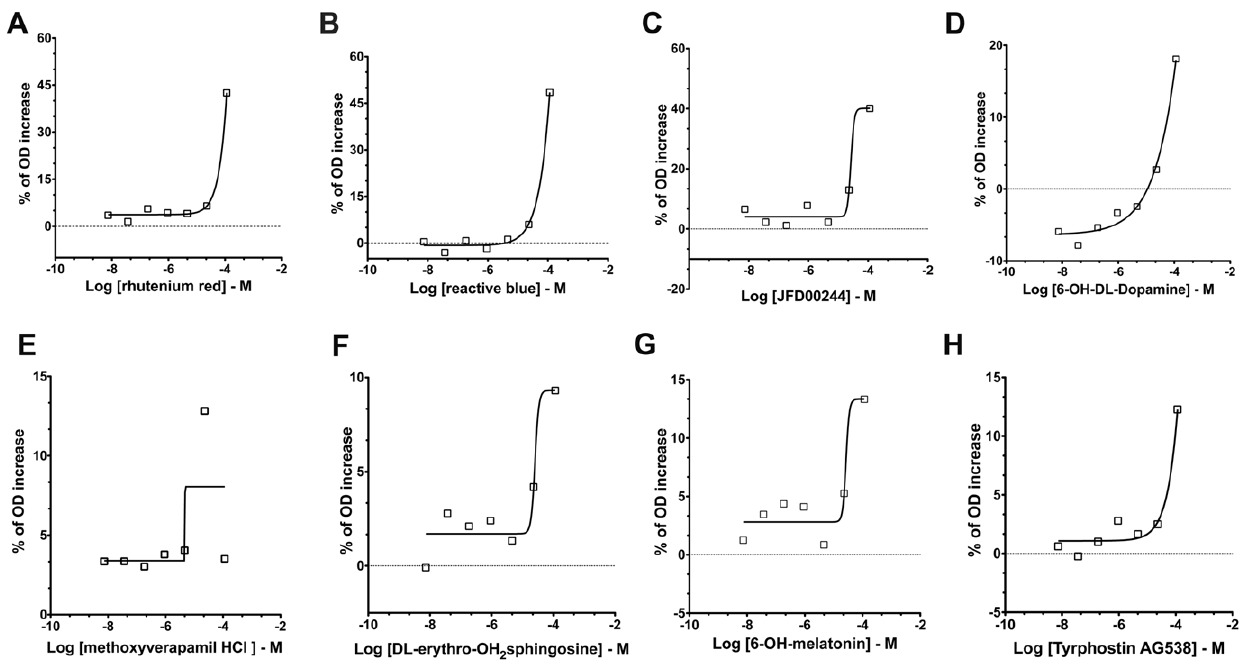
Figure 7. Concentration-response curve analysis obtained from the quantitative cell-based HTS assay for ASA against LOPAC library. In the cell-based HTS for ASA using LOPAC concentrations ranging 7 6 10 2 3 - 114.2 microM, two compounds, ruthenium red ( A ) and reactive blue ( B ), showed concentration-response curve of class 2.2 (partial curve; r 2 $ 0.9; efficacy # 80%). Other two small molecules, JFD00244 ( C ) and 6-OH- DL-Dopamine ( D ) also presented concentration-response curves of class 2.2. Four small molecules, methoxyverapamil HCl ( E ), DL-erythro- dihydrosphingosine ( F ), 6-OH-melatonin ( G ) and I-Me-Tyrphostin AG 538 ( H ) showed concentration-response curves of class 2.4 (partial curve; r 2 # 0.9; efficacy Min. 2